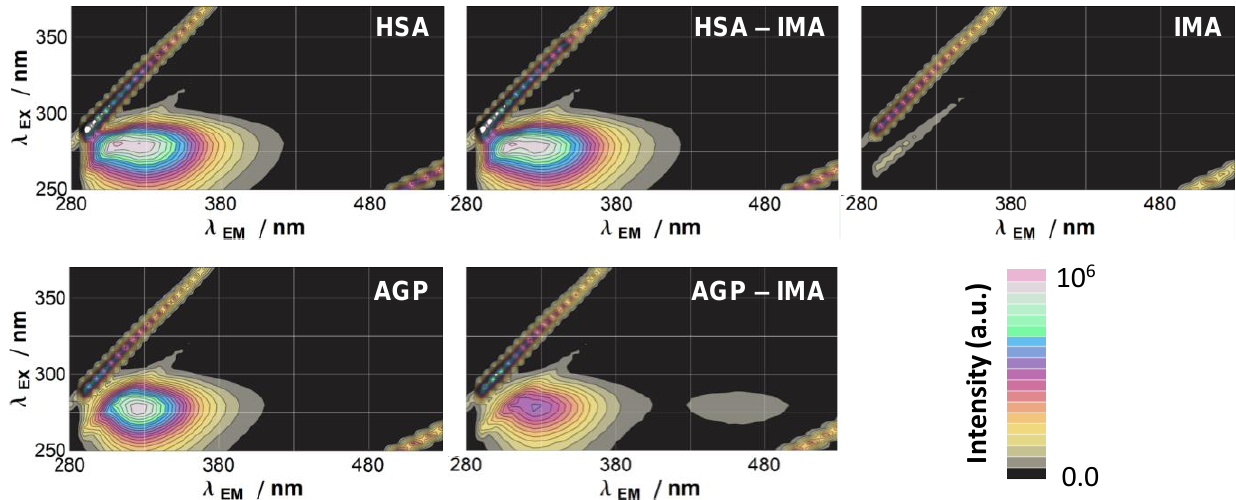
Figure 9. Three-dimensional fluorescence spectra of the HSA – IMA and AGP – IMA systems [ c HSA = 1.0 μM; c AGP = 0.53 μM; c IMA = 4.6 μM; pH = 7.4 (PBS); t = 25 °C]. Further titration experiments were carried out, to gain a deeper understanding of the binding interaction. Representative emission spectra obtained from the titration of the AGP – IMA system are presented in Figure 10. The fluorescence of AGP mainly originates from the three Trp amino acid residues. The binding of IMA effectively quenches this fluorescence and, in parallel, the induced emission band of IMA shapes a saturation curve (Figure 10). The position of the emission peak ( λ EM = 465 nm) together with the excitation